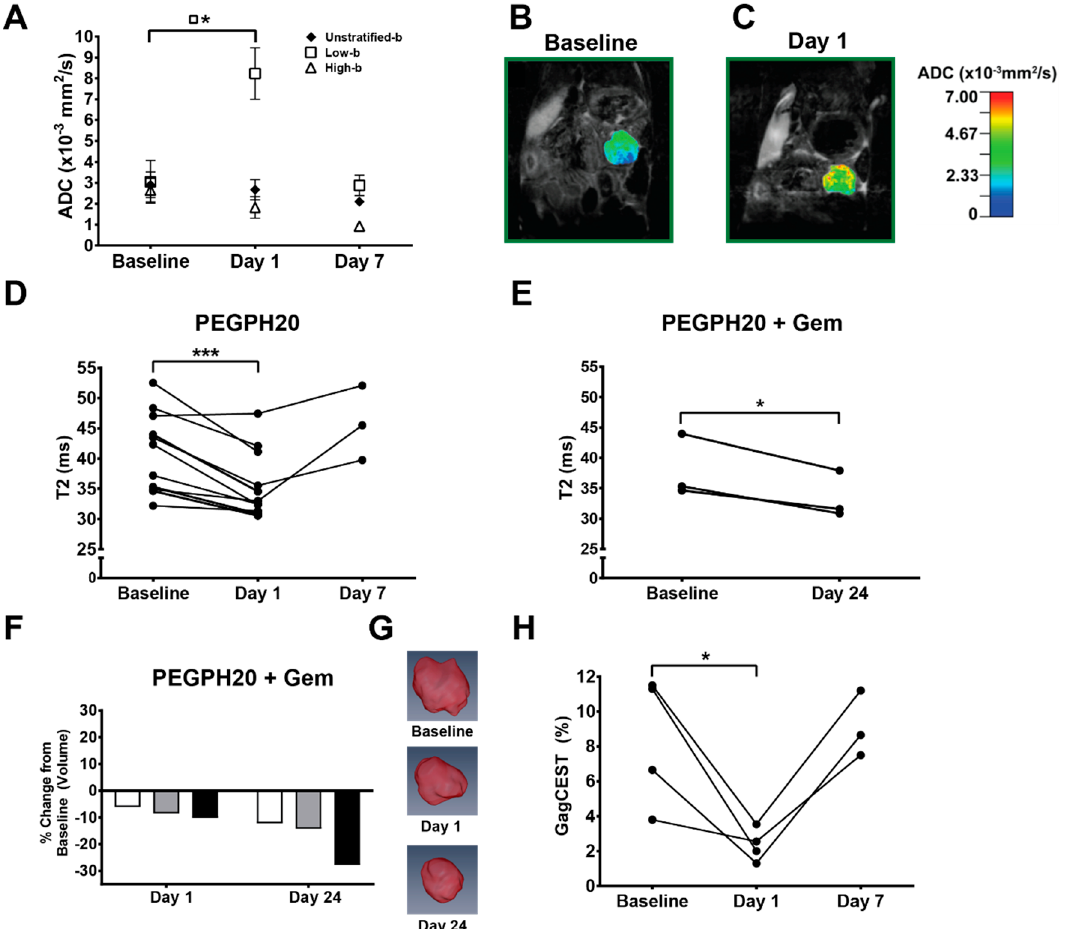
Figure 2. Multiparametric MRI results. ( A ) Unstratified and stratified apparent di ff usion coe ffi cient (ADC) values at baseline ( n = 4), day 1 ( n = 4), and day 7 ( n = 3); points = means, error bars = SEM. Low b-values = 7, 47, 81 s / mm 2 . High b-values = 126, 180, 234, 340, 549 s / mm 2 . ( B , C ) Representative ADC color-overlay maps on proton density weighted anatomic, coronal plane images from a KPC mouse at baseline ( B ) and 24 h ( C ) following PEGPH20 treatment. ( D ) T2 values for animals treated with PEGPH20 at baseline ( n = 11), day 1 ( n = 11), and day 7 ( n = 3). ( E ) T2 values for animals that underwent one full 3-week cycle of PEGPH20 + gemcitabine combination therapy ( n = 3). ( F ) Tumor volume measurements ( n = 3) plotted as percent change from baseline for animals that underwent the 3-week PEGPH20 + gemcitabine regimen. ( G ) Three-dimensional volumetric renderings from a representative KPC animal treated with PEGPH20 + gemcitabine regimen at baseline, day 1, and day 24. ( H ) Glycosaminoglycan chemical exchange saturation transfer (GagCEST) values at baseline, day 1 and day 7 after PEG monotherapy ( n = 3). * = p < 0.05; *** = p <